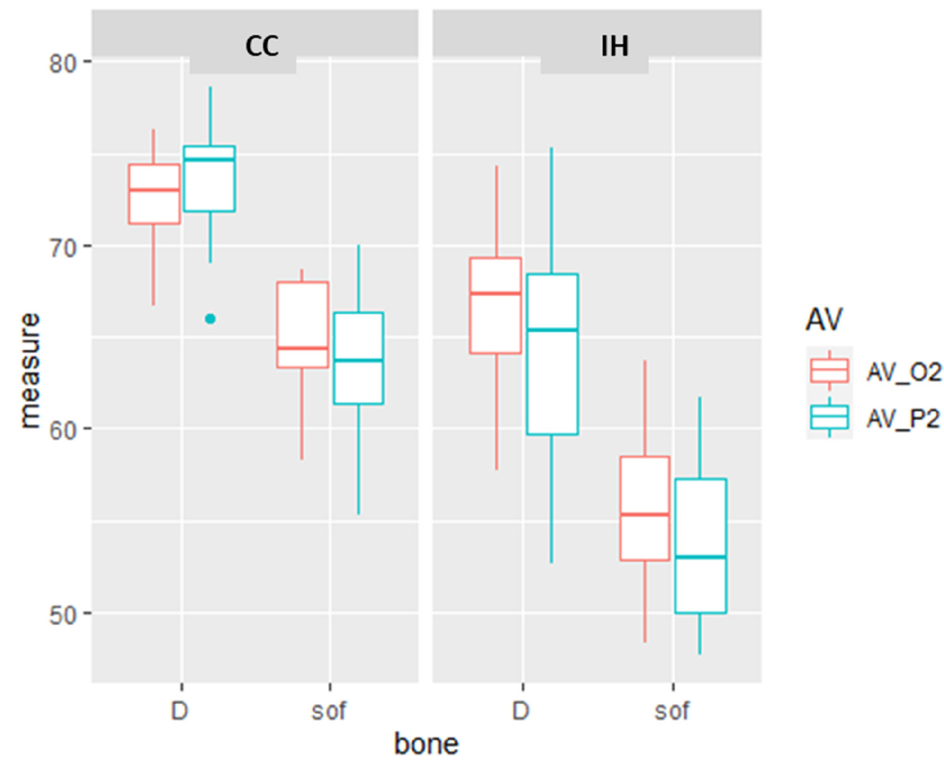
Figure 3. The effect of implant design and bone type on implant stability. Box and whiskers plot of the RFA measurements of Osstell (O2) and Penguin (P2) in the D = dense and sof = soft bone type, in CC and IH implant design. The box represents the interquartile range and the median, and the whiskers represent the SD. There are some values that are outliers. Table 2. The difference of average implant stability measurements between the tested parameters of bone type (soft or dense) and implant type (IH or CC) by the IT, Osstell (O2), and Penguin (P2) devices.